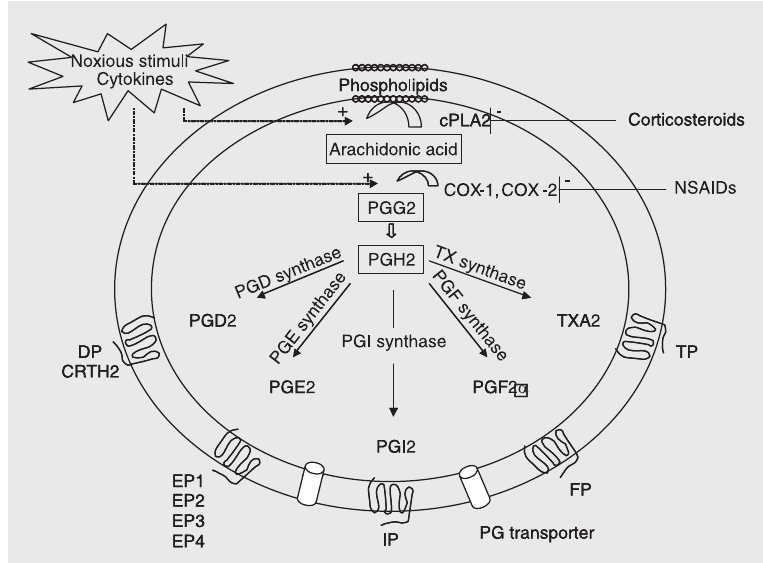
Figure 2. Biosynthesis of prostanoids. The biosynthesis of prostanoids begins when phos- pholipases break down cell membrane phospholipids into arachidonic acid, which is the substrate for the prostaglandin H (PGH) synthases (also known as cyclooxygenases). Prostanoids are synthesized by the metabolism of PGH by various isomerases such as PGE synthase and TX synthase. After synthesis, prostanoids exit the cell via prostaglandin transporters and bind to specific G protein coupled receptors present on the surface of neighboring cells. cPLA2 = cytosolic phospholipase A2; COX = cyclooxygenase; NSAIDs = non-steroidal anti-inflammatory drugs; PG = prostaglandin; TX = thromboxane; CRTH2 = chemoattractant receptor-homologous molecule expressed on Th2